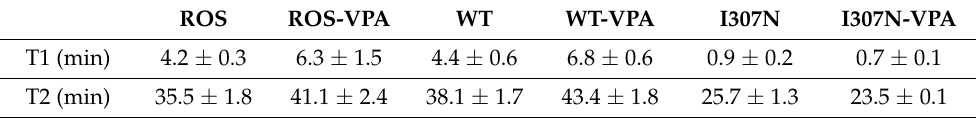
Table 2. Thermal Decay Rates: Results of the first (T1) and second (T2) half-life times (t 1/2 ) for the thermal stability of the purified ROS, WT, and I307 mutant Rhos, in the dark state. The decrease of the visible absorbance maximum with time was followed at 48 ◦ C in the dark and the half-life times for the thermal decay were determined as described under the Materials and Methods section.